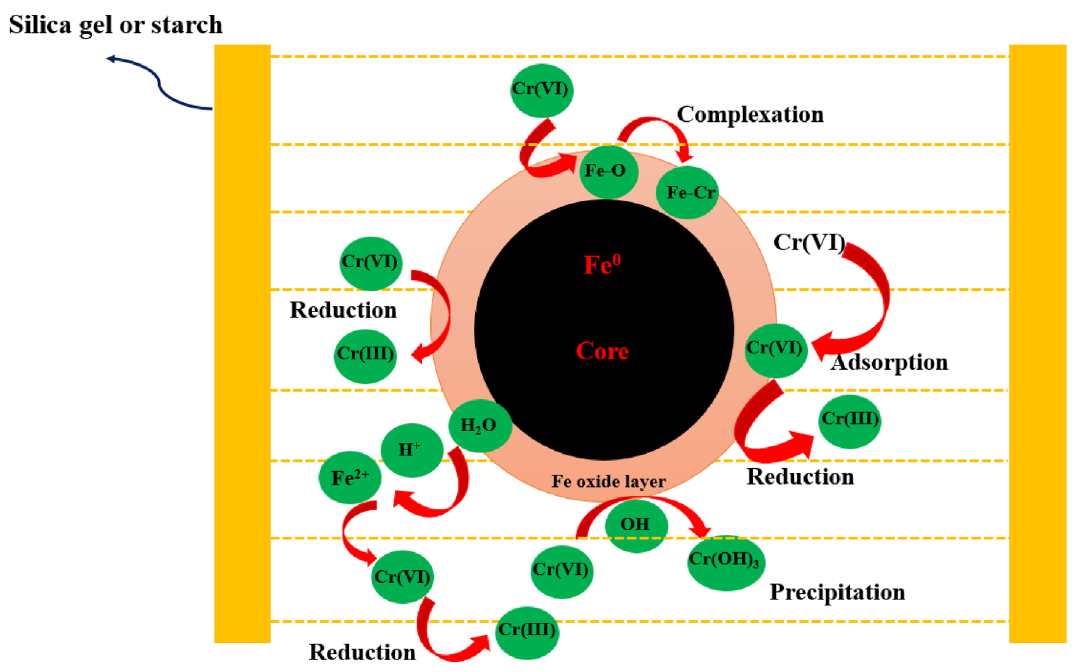
Figure 13. Removal mechanism of Cr(VI) by